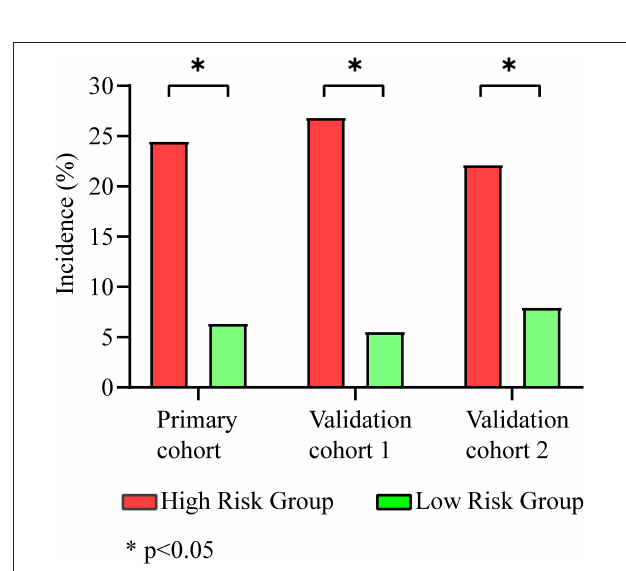
FIGURE 3 | Incidence of CRT in different groups. The high-risk group had a higher incidence of CRTs than the low-risk group in the primary cohort (24.5 vs. 6.4%), validation cohort 1 (26.8 vs. 5.6%), and validation cohort 2 (22.2 vs.